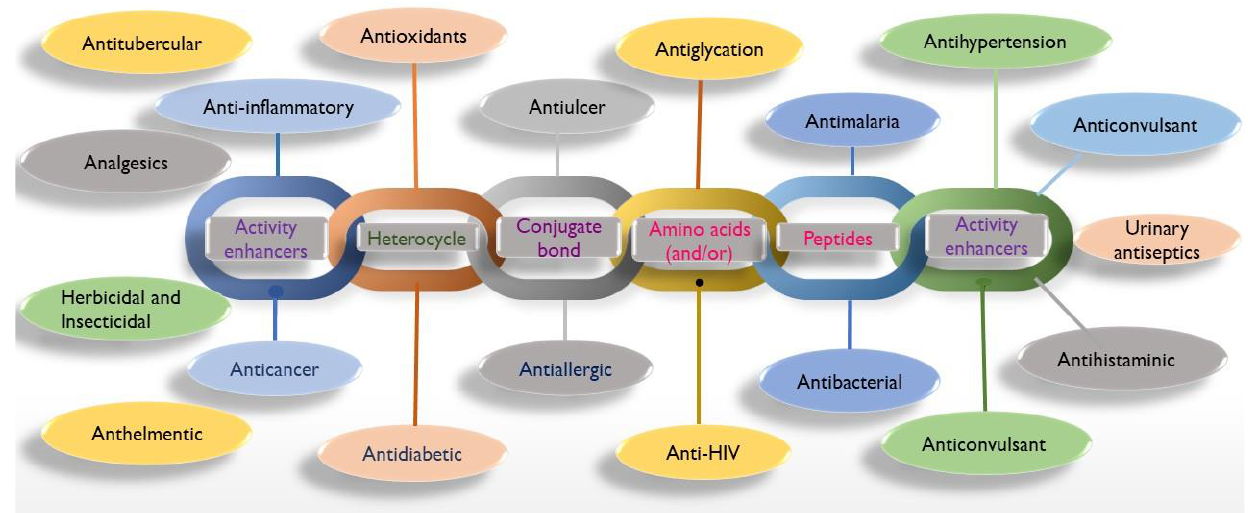
Figure 10. Different therapeutic applications of the conjugates.